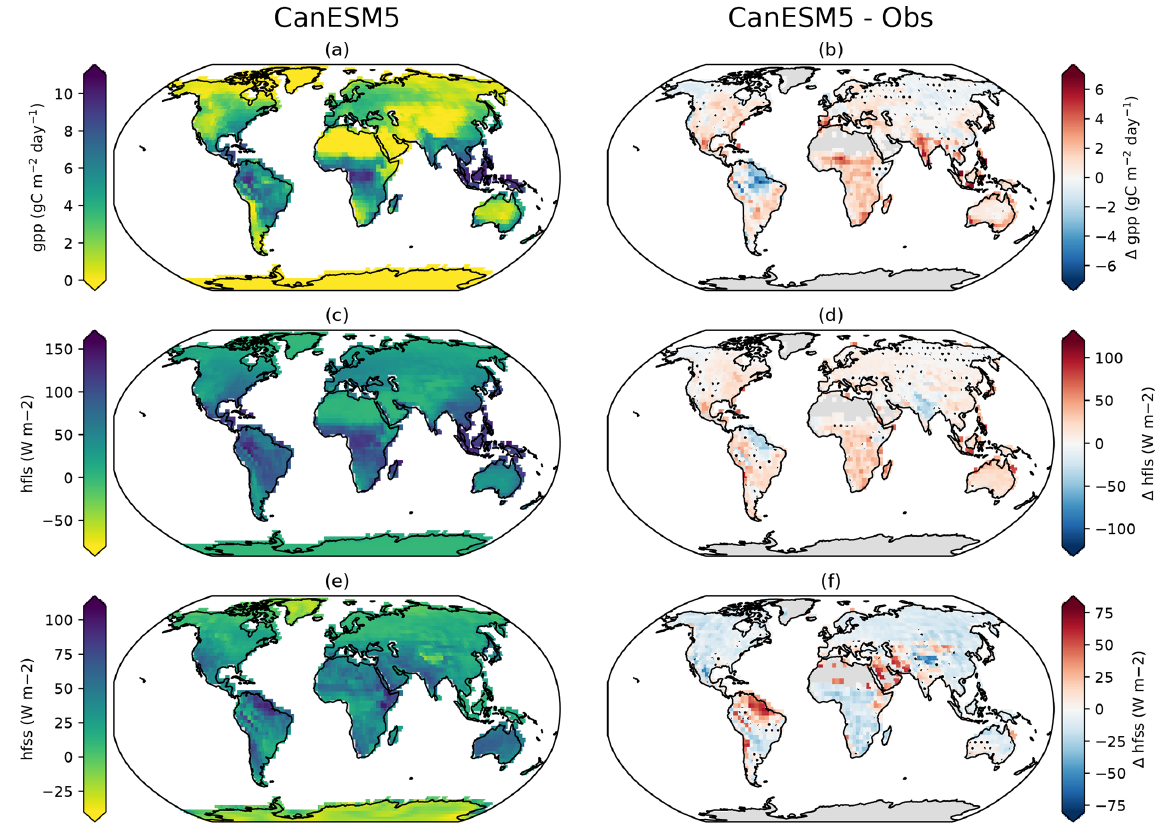
Figure 12. Time-mean values of (a) gross primary productivity (GPP), (c) latent heat flux (hfls), and (e) sensible heat flux (hfss) from CanESM5 (r1i1p1f1) (a, c, e) and the corresponding biases with respect to observation-based reference data presented in Jung et al. (2009) (b, d, f) . Black dots mark grid cells where biases are not statistically significant at the 5% level using the two-sample Wilcoxon